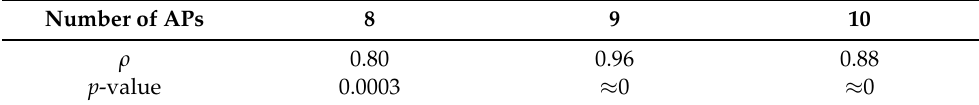
Table 6. Pearson correlation test between simulated and experimental results for the localization error.